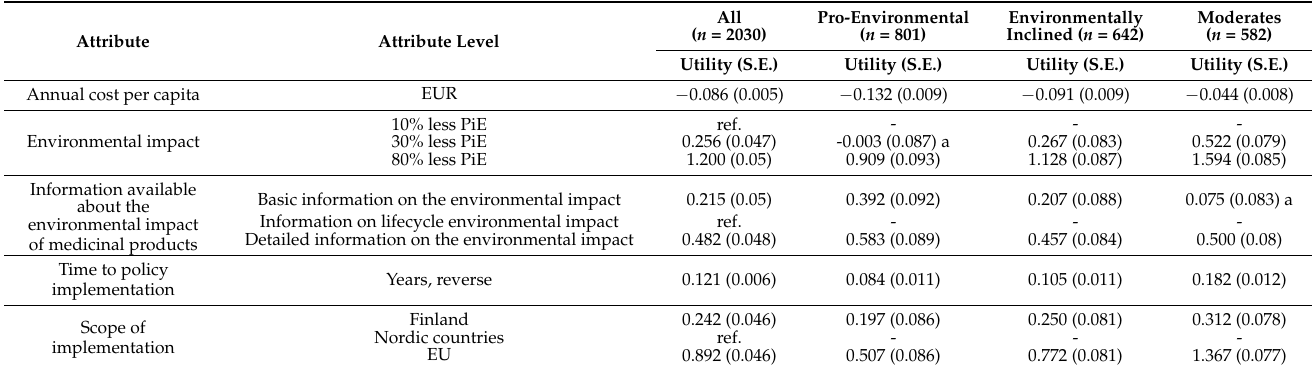
Table 4. Utilities of the attribute levels among the respondents and latent classes.